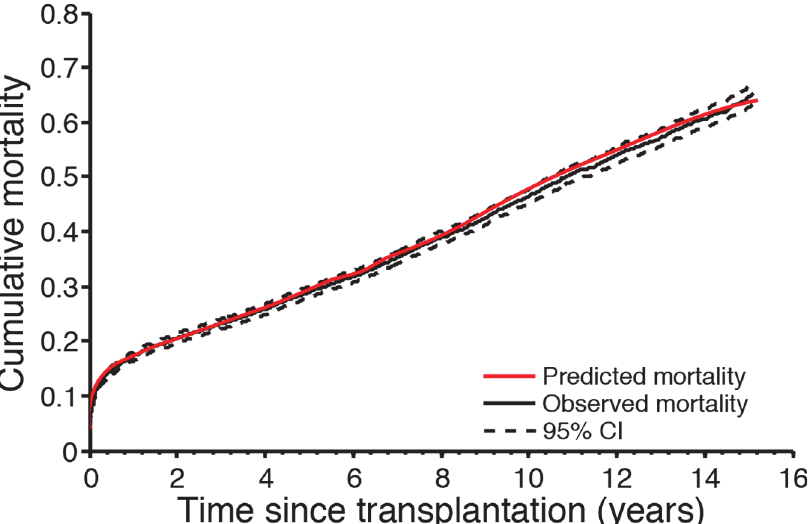
Fig 2. Cumulative mortality for the internal validation cohort (IVC). The black solid line shows the observed cumulative mortality and dotted lines show the 95% confidence interval (estimated with Kaplan- Meier failure function) in the IVC. The red solid line shows the predicted survival for transplanted patients in the